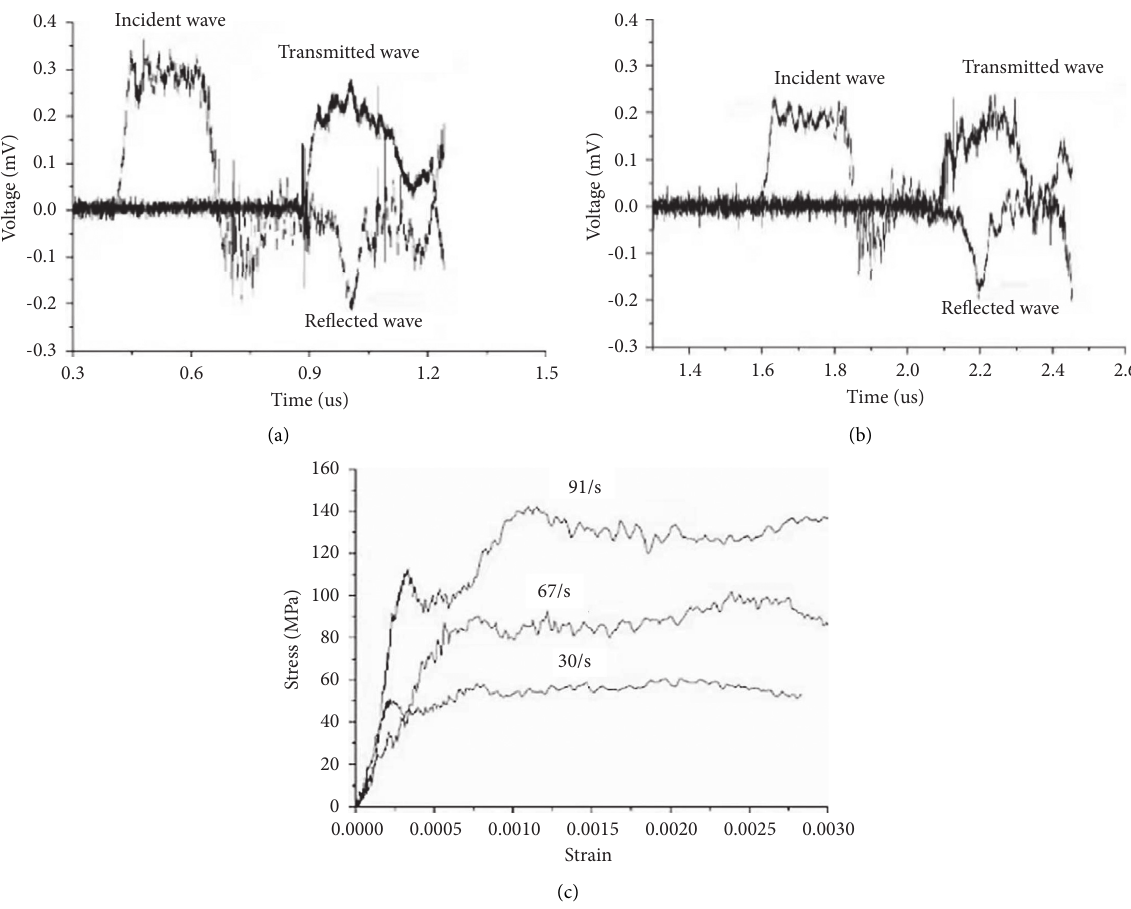
Figure 3: Voltage-time and stress-strain curves of desert sand concrete. (a) The strain rate of 29/s (M1). (b) The strain rate of 30/s (M6). (c) Stress-strain